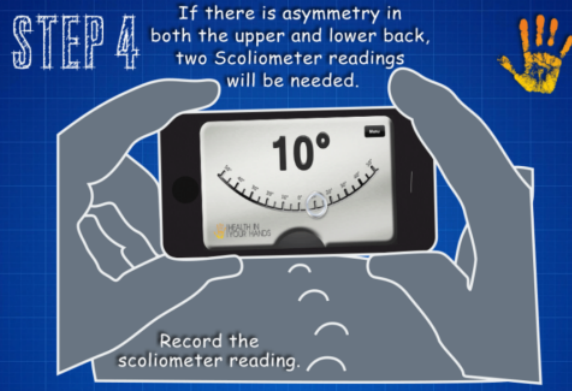
Figure 4. Scoliometer. (This figure is a snapshot taken by the screen of the